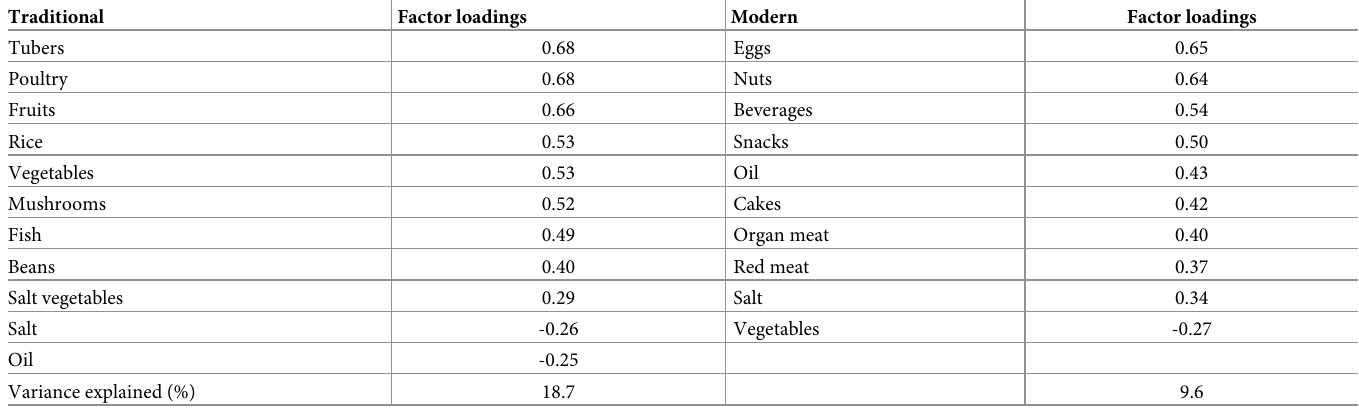
Table 2 summarizes the two dietary patterns among the participants. The first one was labeled as the traditional pattern, which characterized by high intakes of tubers, poultry, rice, fruits, vegetables and low intakes of oil and salt. The other one which highly correlated with egg, nut, beverage and snack intakes, was named as the modern pattern. The two dietary pat- terns explained 28.3% of the total variance in dietary consumptions. Table 2. Factor loadings of the food groups in the two dietary